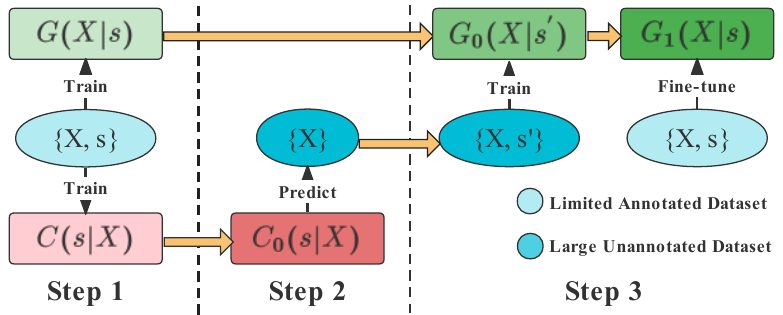
Figure 2. Illustration of the training steps for the generator and classifier. Note that “X”, “s”, “G”, and “C” represent the review text, fine-grained sentiment, generator, and classifier,